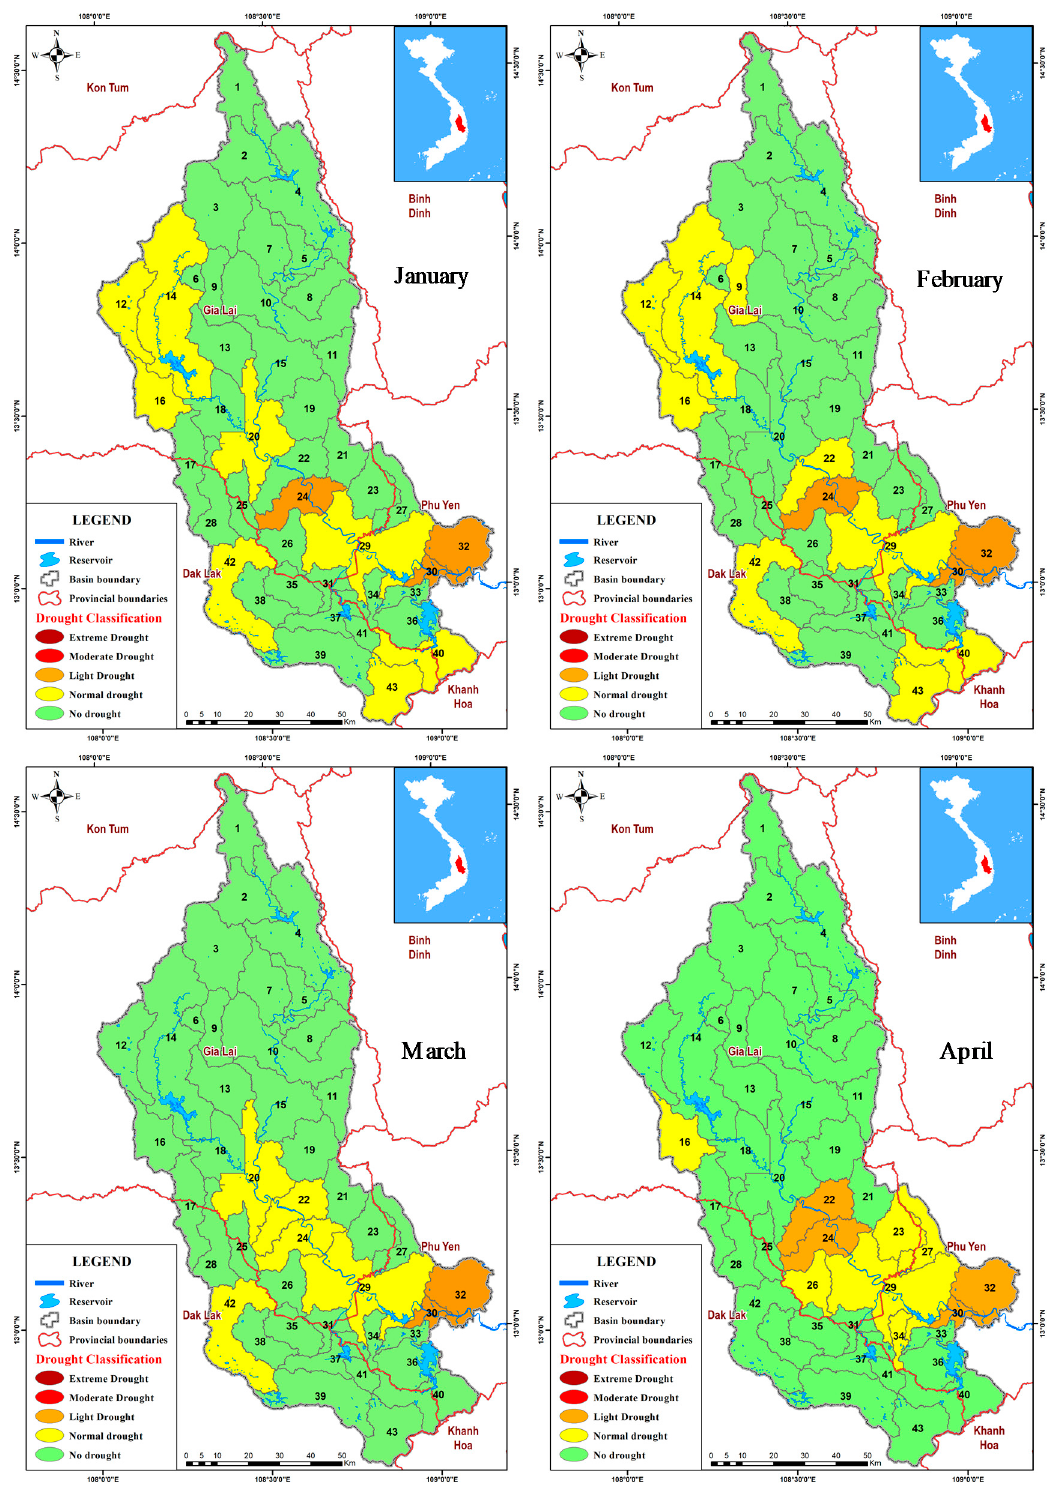
Figure 7. The average drought classification maps from January to April for the period 1981–2016 in the Ba River basin.